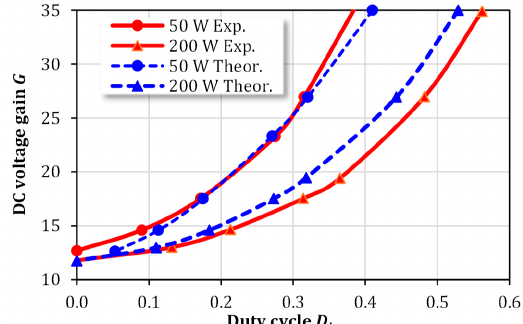
Figure 10. Calculated and measured DC voltage gain of the converter versus the duty cycle at two input power levels.